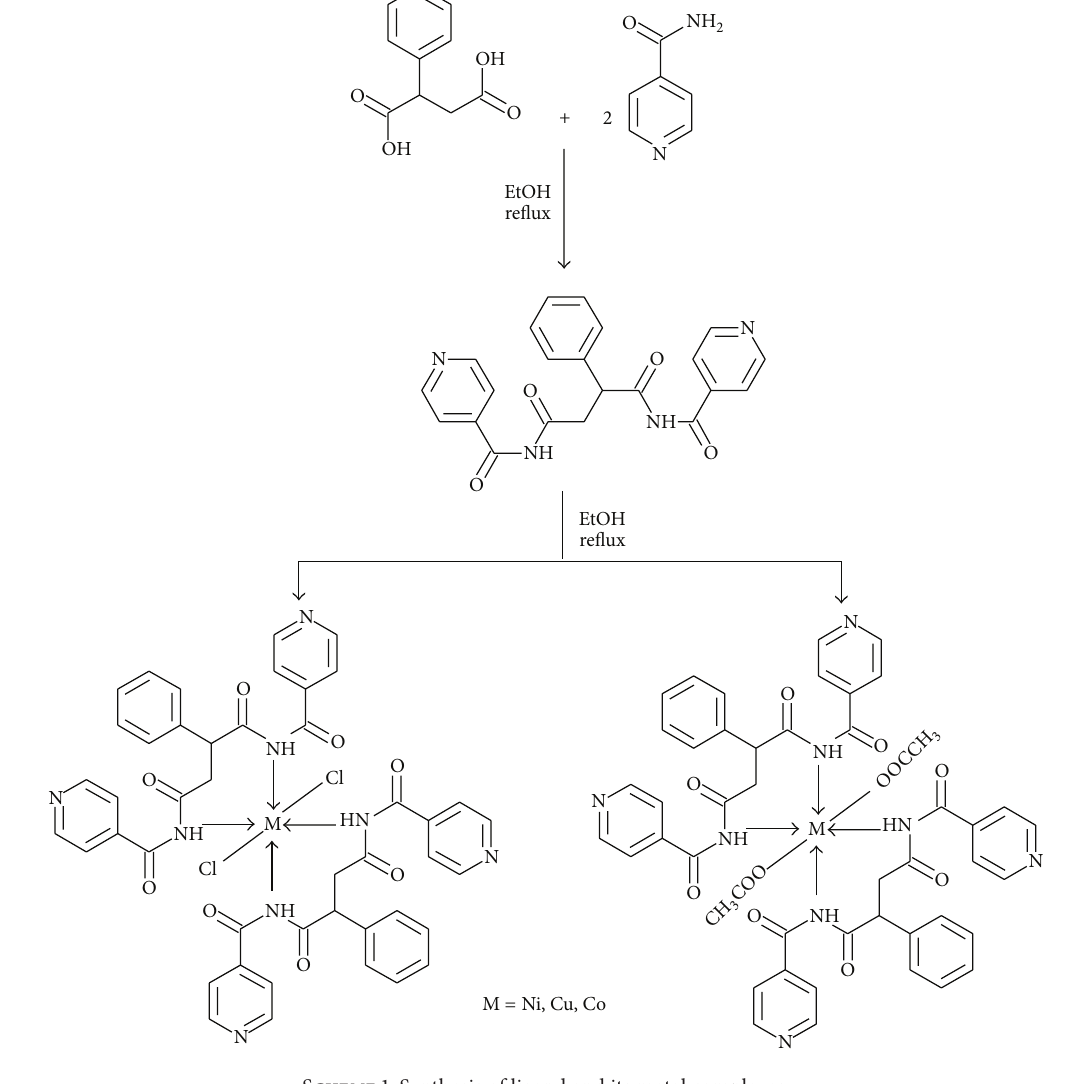
Scheme 1: Synthesis of ligand and its metal complexes.